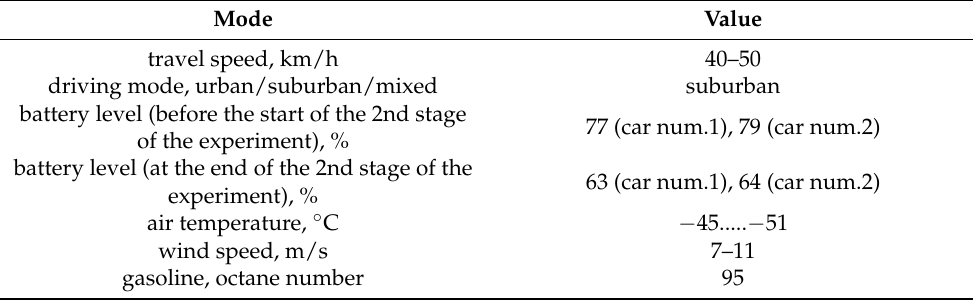
Table 4. Actual modes of the experiment.